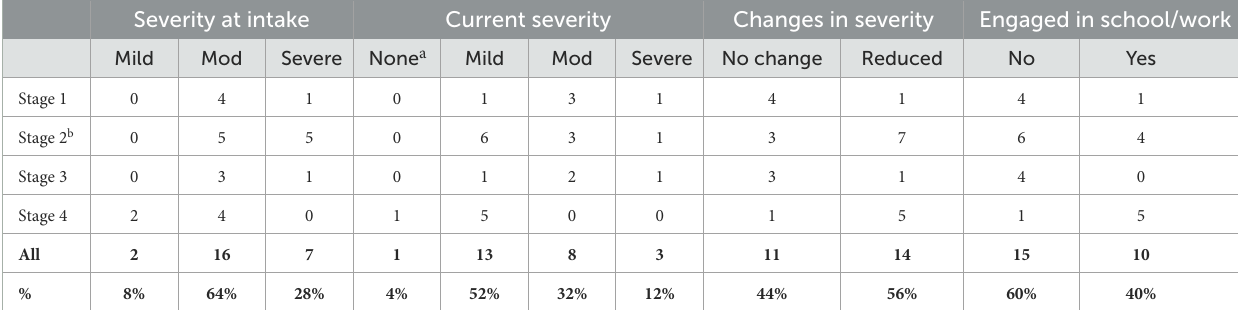
TABLE 2 Case progress at each stage of intervention ( N =